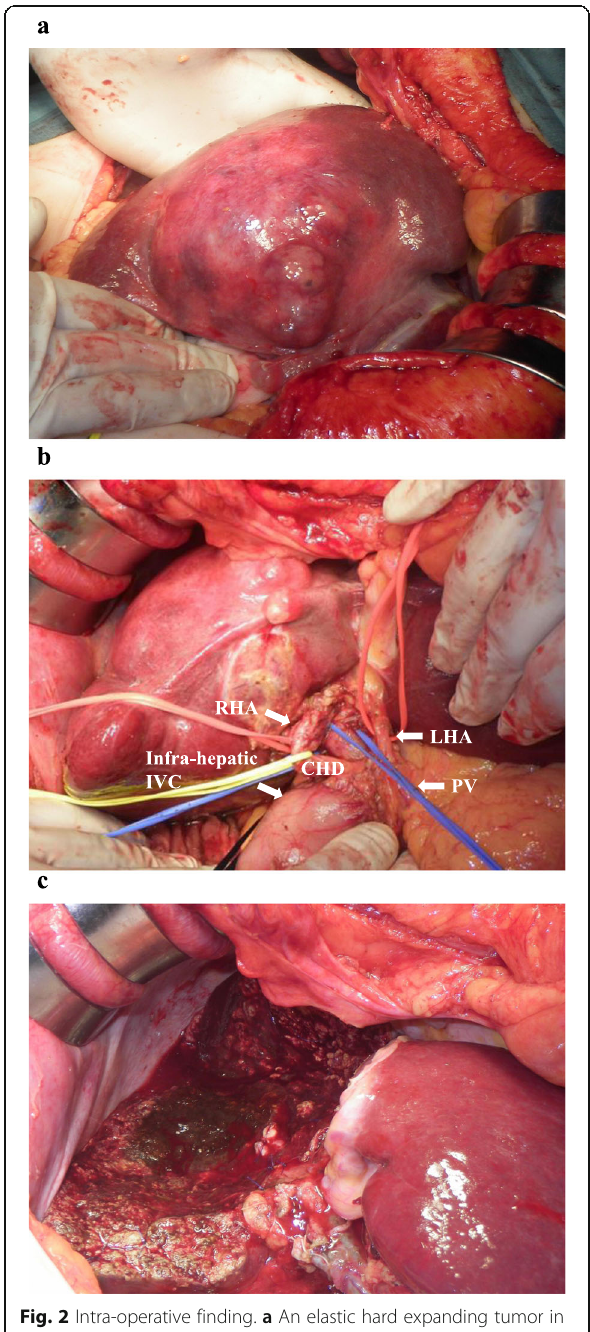
Fig. 2 Intra-operative finding. a An elastic hard expanding tumor in the segments 4, 5, and ventral site of the segment 8. b Hepatic hilum dissection and encircling of the infra-hepatic IVC with a tape. RHA: right hepatic artery; LHA: left hepatic artery; CHD: common hepatic duct; PV: portal vein; IVC: inferior vena cava. c Completion of the central hepatectomy without the caudate lobectomy of the